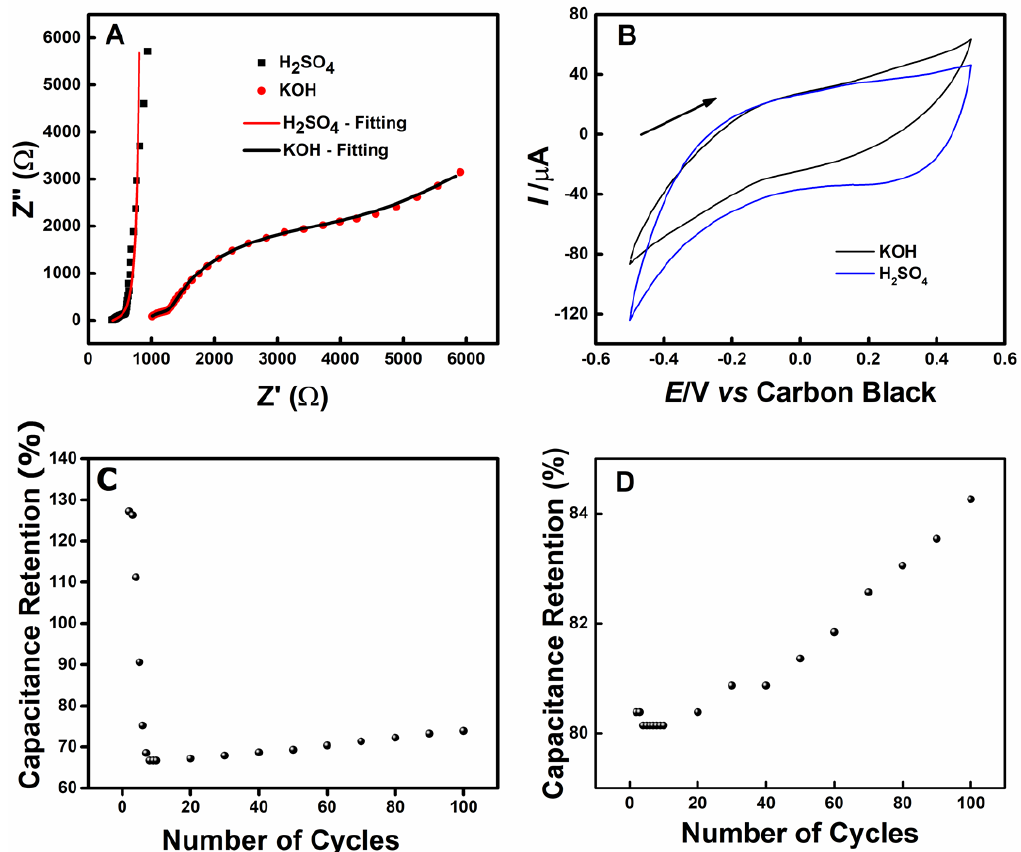
Figure 3. ( A ) Nyquist diagrams for H 2 SO 4 ( ■ ) and KOH ( ● ). ( B ) Cyclic voltammograms obtained in OCP by 66.7/33.3% CB/CA electrode, in equimolar 1.0 mol L − 1 H 2 SO 4 ( ▬ ) and KOH ( ▬ ); ν = 10 mV s − 1 . Capacitance retention dispersion plots of 100 cycles in ( C ) 1.0 mol L − 1 KOH and ( D ) 1.0 mol L − 1 H 2 SO 4 .